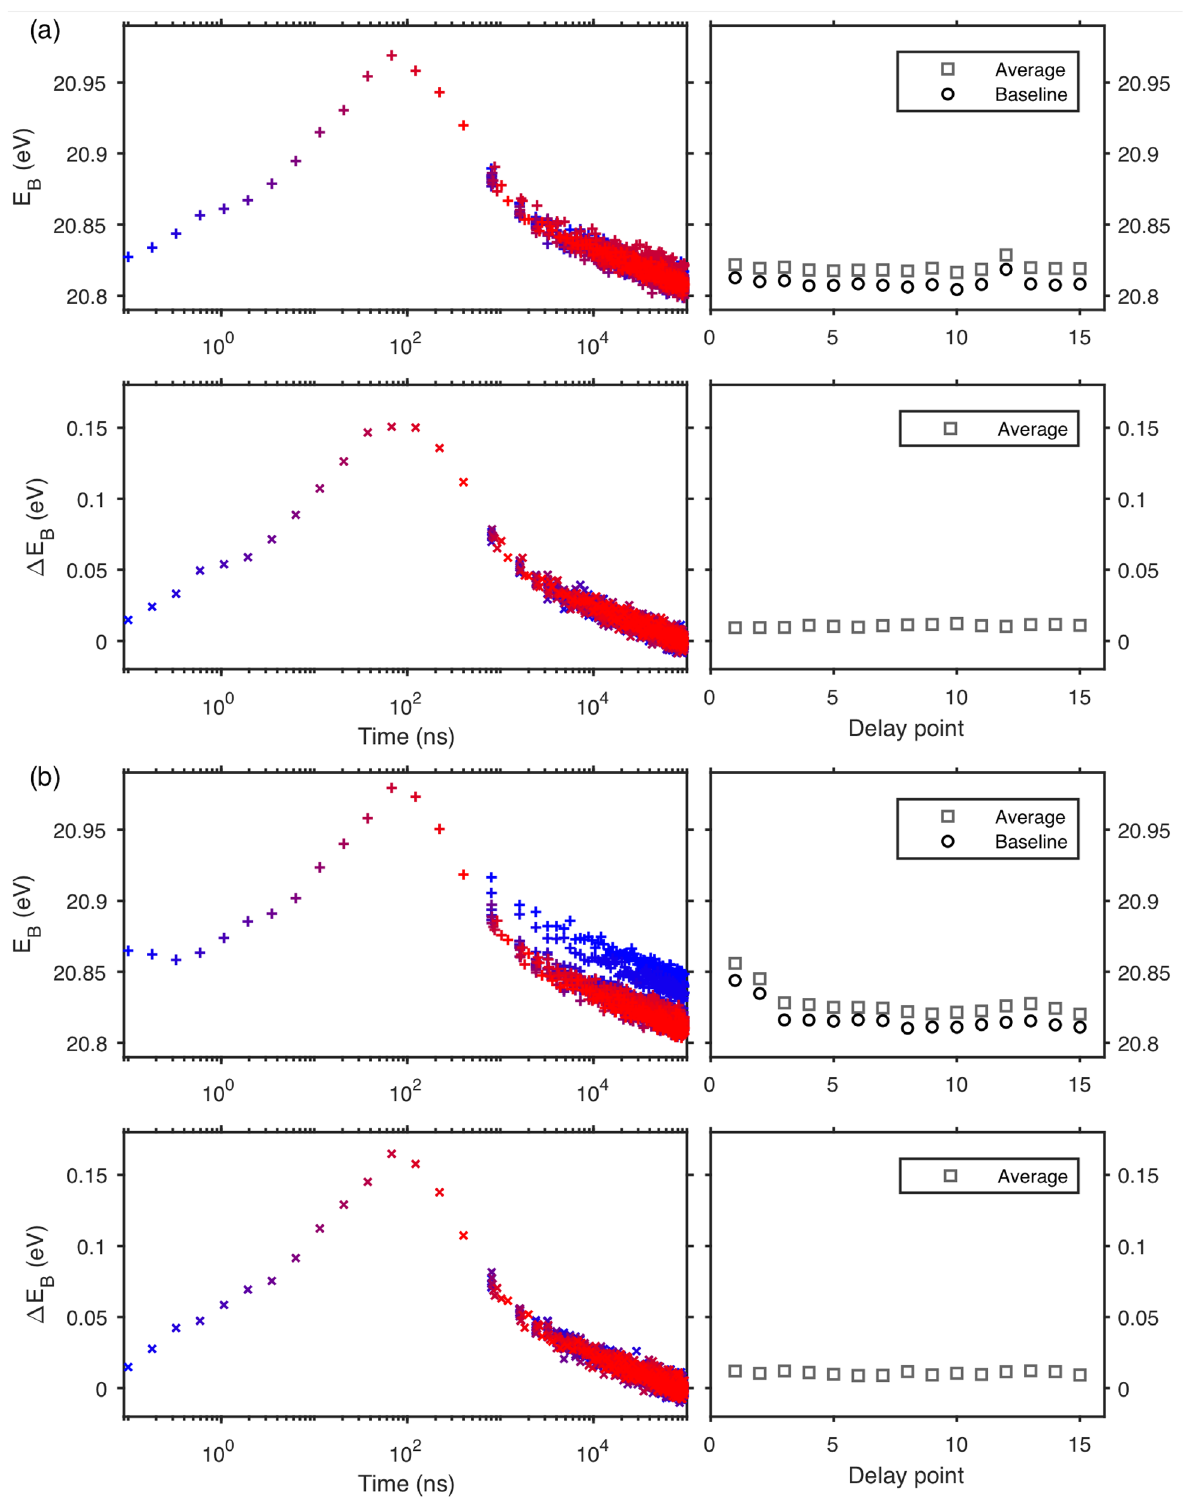
Figure 7. Examples of two delay scans in two different sample spots with a laser pulse energy of 15.4 nJ on a 250 nm thick PbS quantum dot sample presented in panels ( a ) and ( b ). The top left panel of each sub-figure shows the absolute peak positions (average of Pb 5d 3/2 and Pb 5d 5/2 ) obtained from fits with different colours representing results from trigger time map measured with different laser-X-ray delay times. The top right panel shows the average and baseline binding energy values calculated for the different trigger time maps, see text. The bottom left panel shows the peak positions with the baseline subtracted for each trigger time map. The bottom right panel shows the average relative binding energy